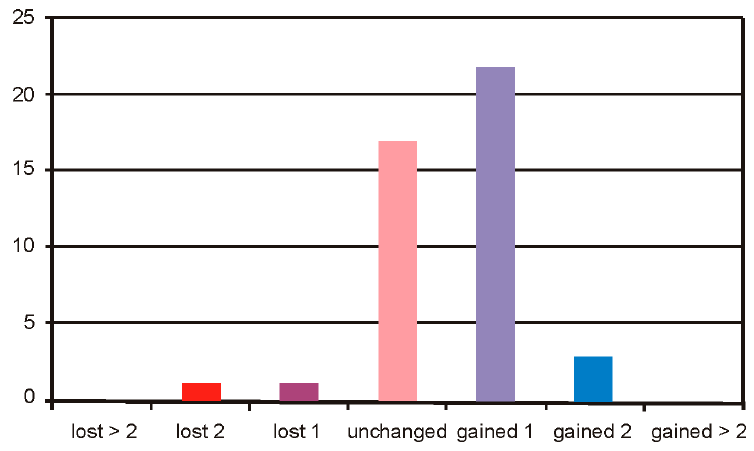
Figure 10. Treatment safety of Group 1.